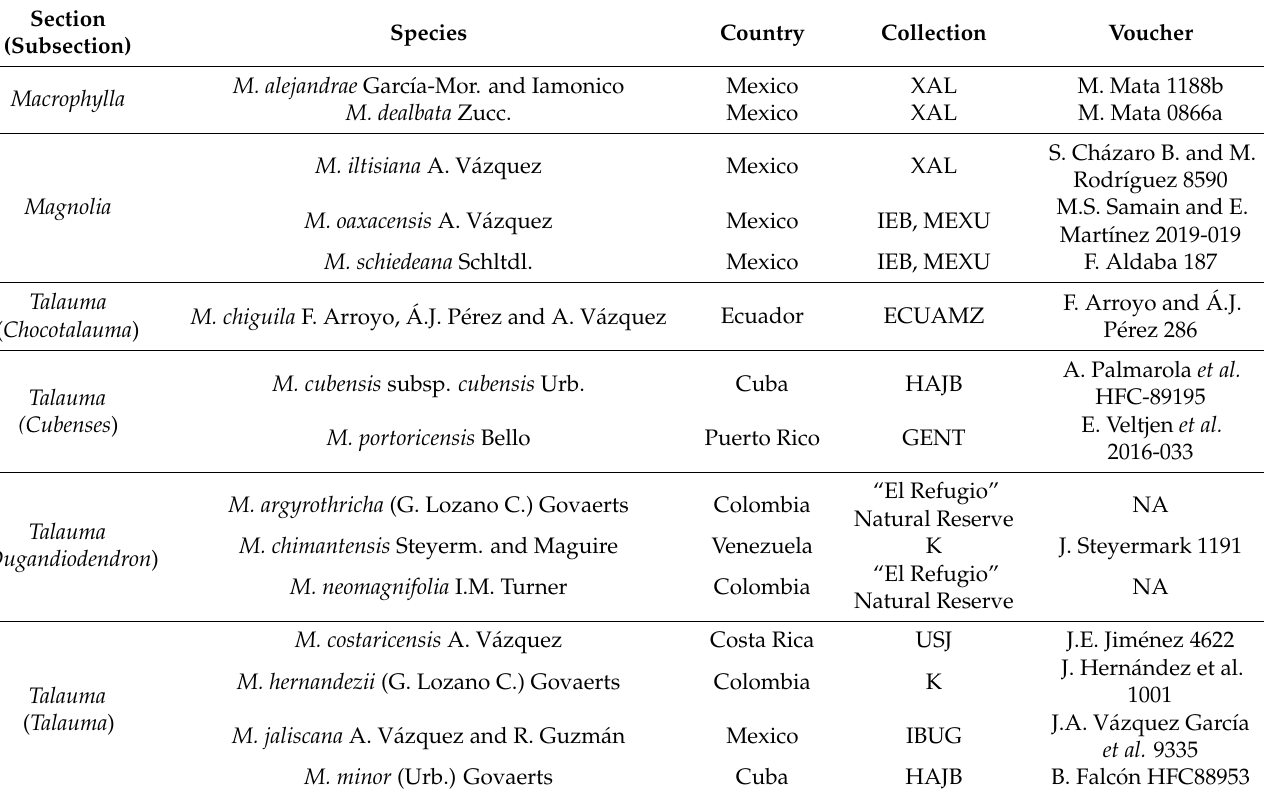
Table 3. Sampled Neotropical Magnolia species. The classification is according to [51,60].